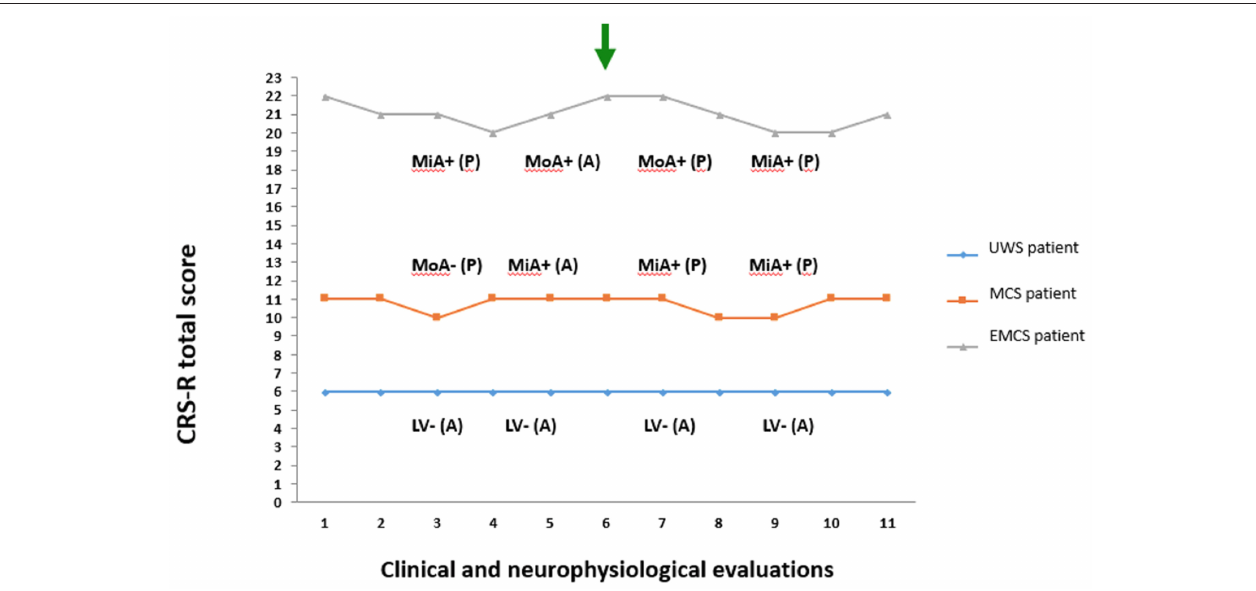
FIGURE 2 | Coma Recovery Scale-Revised total score and neurophysiological (EEG and evoked related potential) evaluations recorded in the 3rd and 5th day before PET/fMRI exam and in the 7th and 9th day after the PET/fMRI exam. The green arrow marks the day of neuroimaging acquisition. The blue diamond and line denote the patient in unresponsive wakefulness syndrome (UWS). The orange square and line denote the patient in minimally conscious state (MCS). The gray triangle and line denote the patient emerged from MCS (EMCS). CRS-R, Coma Recovery Scale-Revised; P, presence of P300 on evoked related potential; A, absence of P300 on evoked related potential; + , presence of EEG reactivity to eye opening and closing; – , absence of EEG reactivity to eye opening and closing; MiA, mildly abnormal EEG background activity; MoA, moderately abnormal EEG background activity; DS, Diffuse slowing EEG background activity; LV, Low voltage EEG background